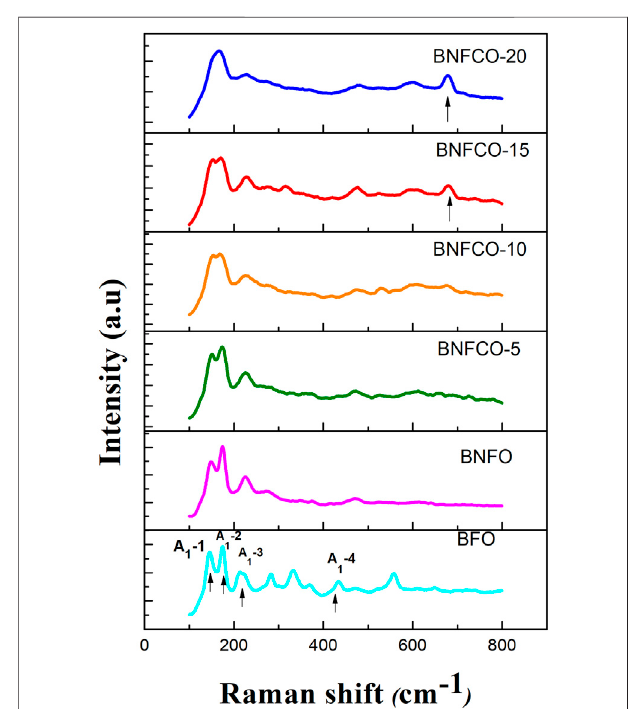
FIGURE3| RamanspectraoftheBi 1-x Nd x Fe 1-y Co y O 3 (x (cid:1) 0,0.05;y (cid:1) 0, 0.05, 0.10, 0.15, 0.20)